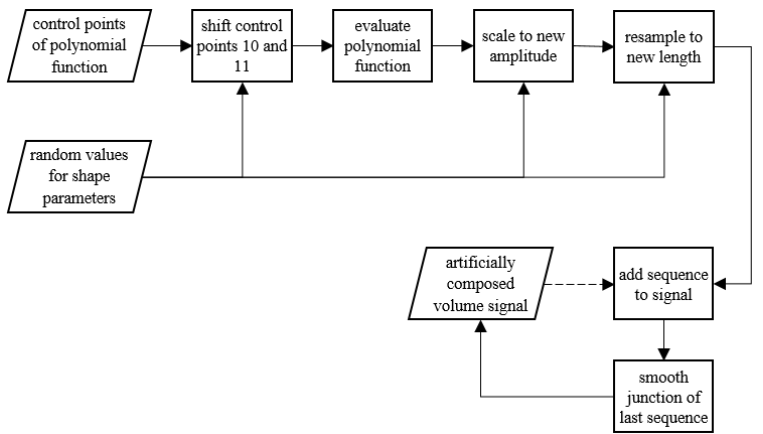
Figure 7. Schematic process of the Monte Carlo simulation comprising the individual sequence manipulation and the composition of the artificially varied volume